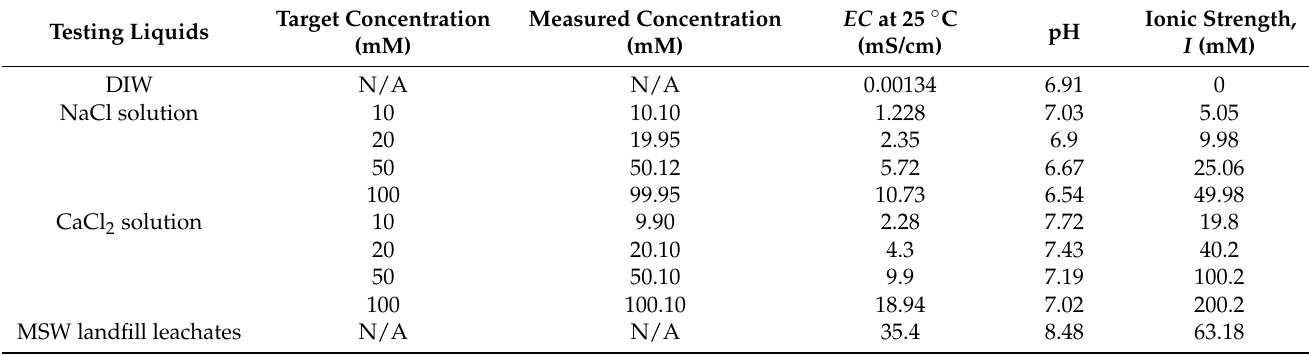
Table 3. The average values of these fundamental chemical characteristics of testing